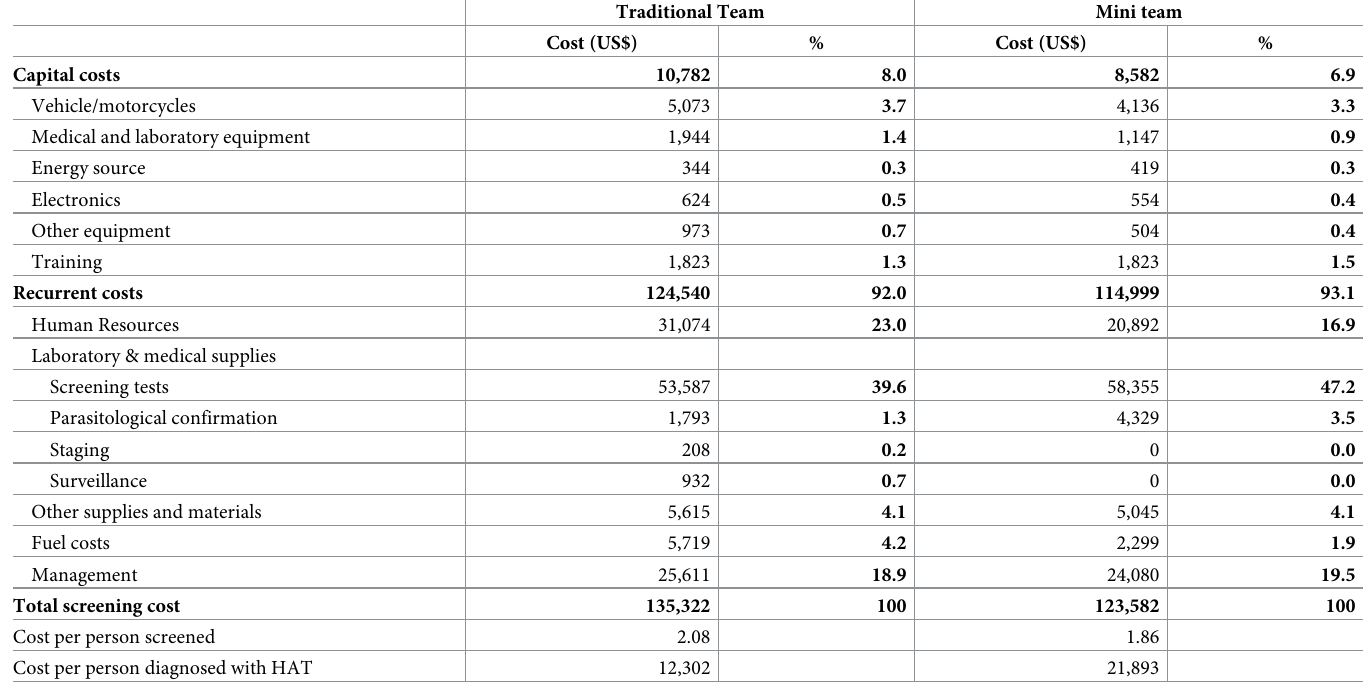
Table 4. Annual economic costs of active screening in Yasa Bonga and Mosango, by screening approach.